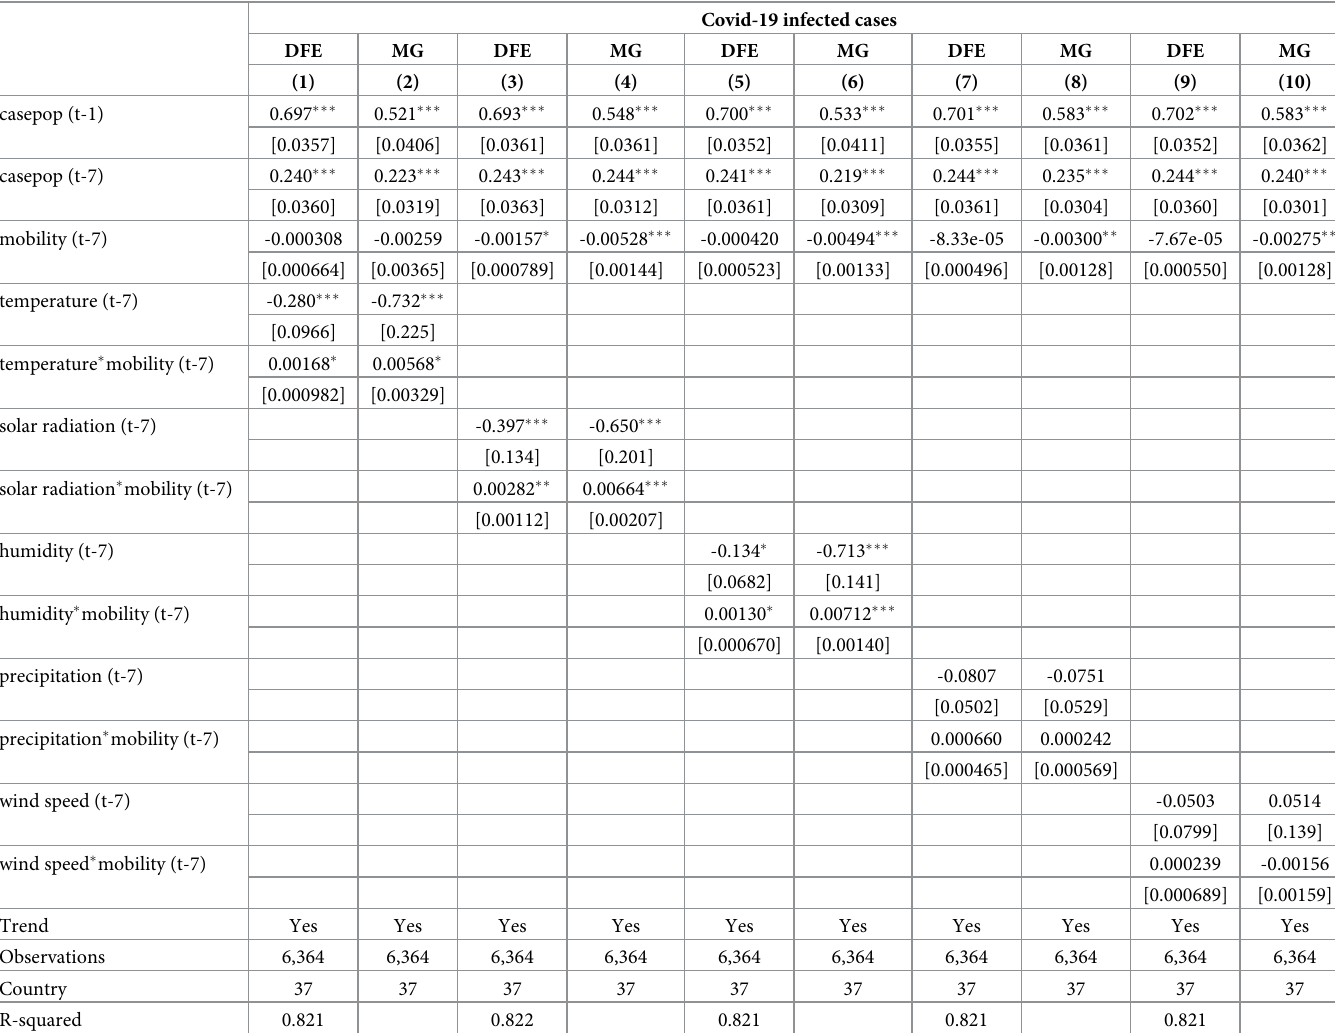
Table 6. Indirect effects of climate variables on Covid-19 infected cases through human